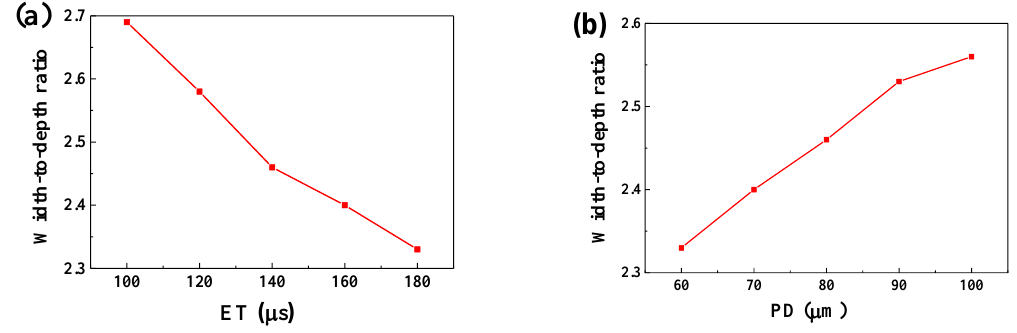
Figure 9. The ratio of width to depth of the melt pool with different ET (PD = 80 μm) ( a ) and different PD (ET = 140 μs) ( b ).